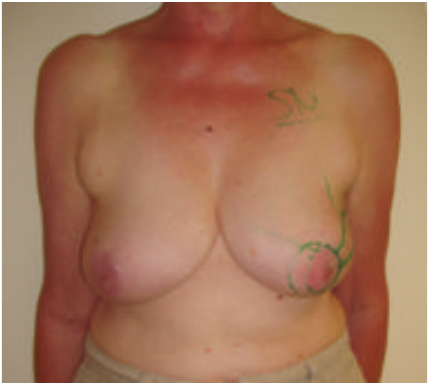
Figure 7: Patient of 69 years, pT2, pN0, resection volume 61g, cup 80B, frontal view.